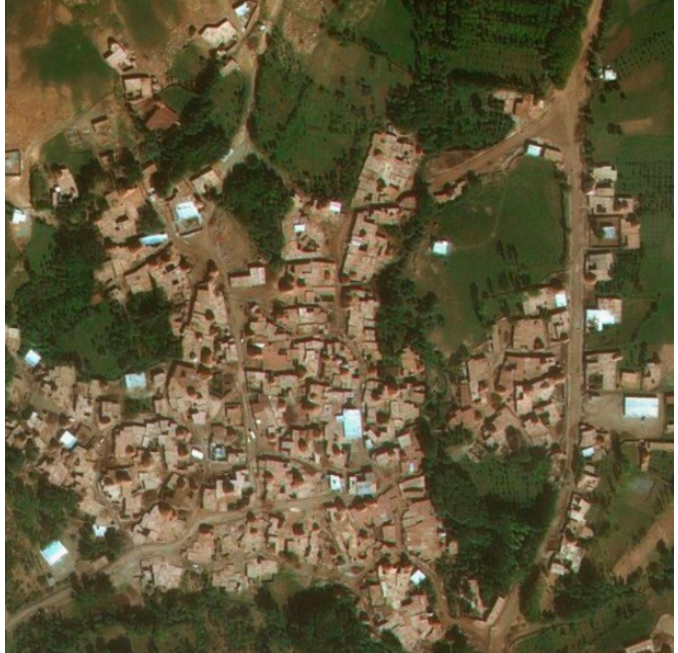
Figure 2. The satellite view of the center of Qinarjeh village (Google Maps 2019, Retrieved 13 February 2019).